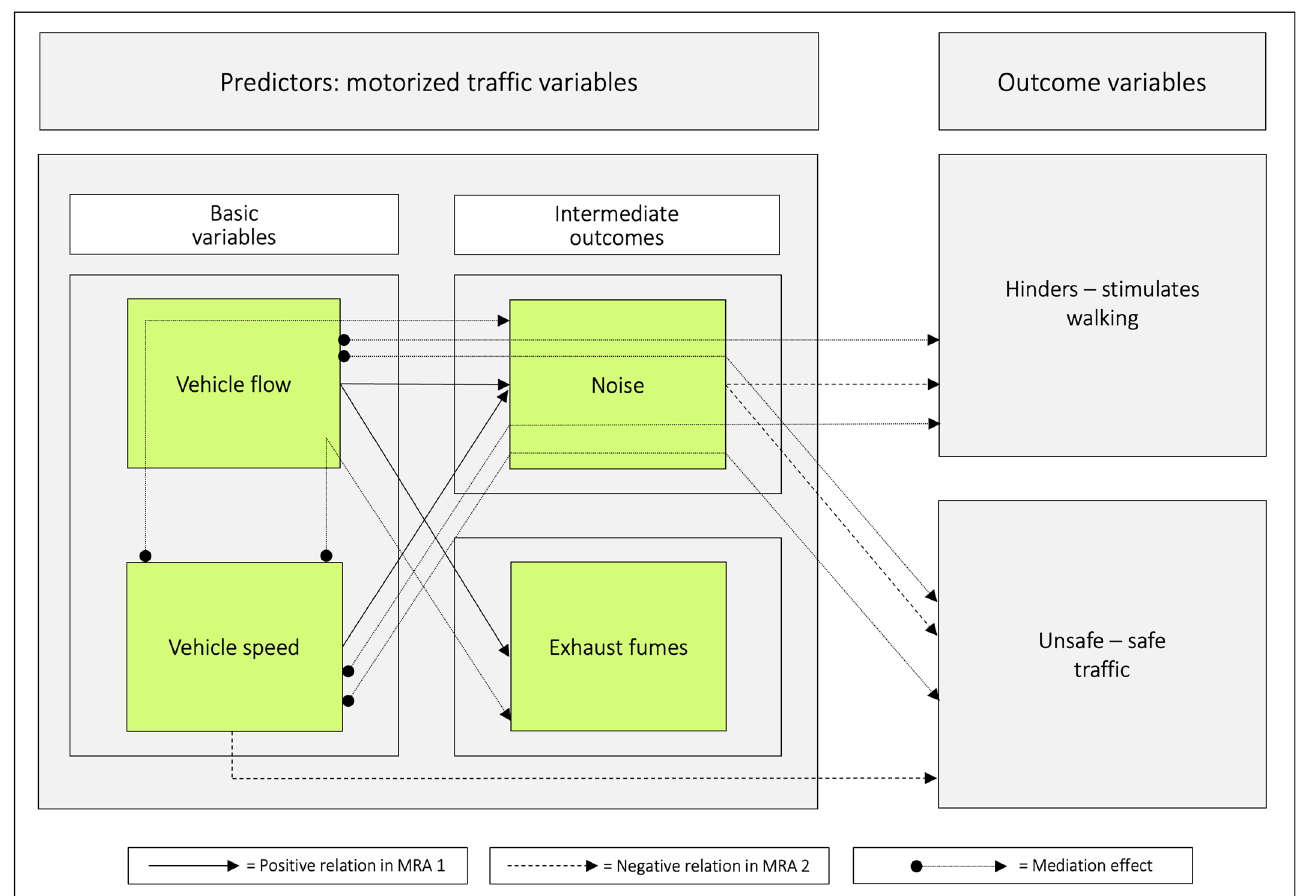
Figure 10. The solid arrows between the predictor variables are based on the multiple regression analyses in Table 6 (MRA 1). They illustrate that when both vehicle speed and vehicle flow were analysed jointly as predictors, they related positively with noise whereas only vehicle flow related to exhaust fumes. The dotted arrows are based on the mediation analyses in Table 9. They illustrate that vehicle speed had an indirect effect on both noise and exhaust fumes , and that both vehicle speed and vehicle flow have indirect effects on both outcome variables via noise . The dashed arrows are based on Tables 7 and 8 (MRA 2). They illustrate that when all traffic variables are analysed jointly as predictors, only noise relates negatively to both outcome variables. Vehicle speed had the same role in relation to unsafe–safe traffic. Given these different roles for vehicle speed , it protrudes as an important origin to the deterring effects of traffic on walking.